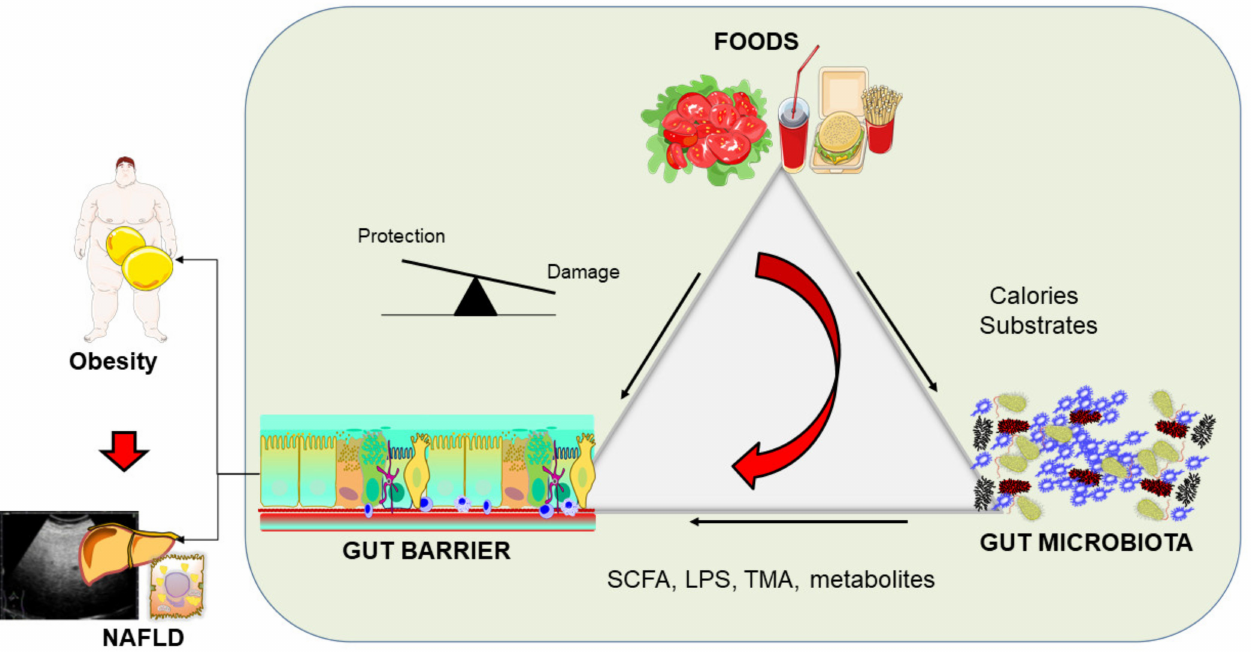
Figure 3. Relationships between foods, gut microbiota and intestinal barrier, as main contribu- tors to obesity and nonalcoholic fatty liver disease (NAFLD). SCFA, short-chain fatty acids, LPS, lipopolysaccharides; TMA,